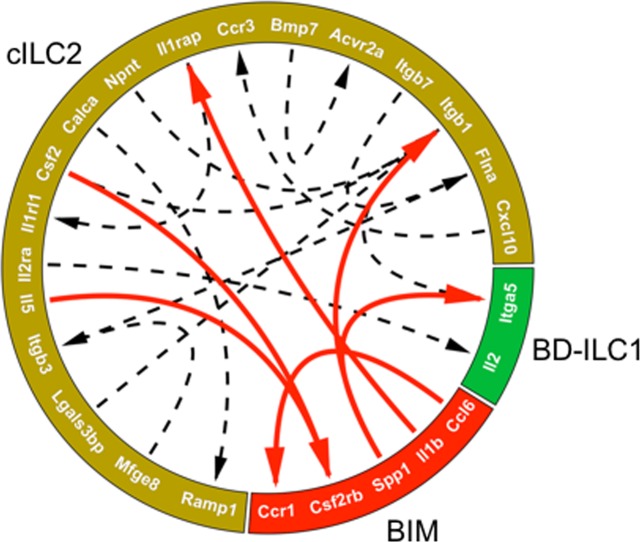
BIM are predicted to interact with ILC2.Predicted receptor-ligand interactions between BIM and either BD-ILC1 or cILC2 isolated from the EHBD (red arrows). Dashed lines represent predicted interactions between cILC2 and BD-ILC1 cell classes in the EHBD.